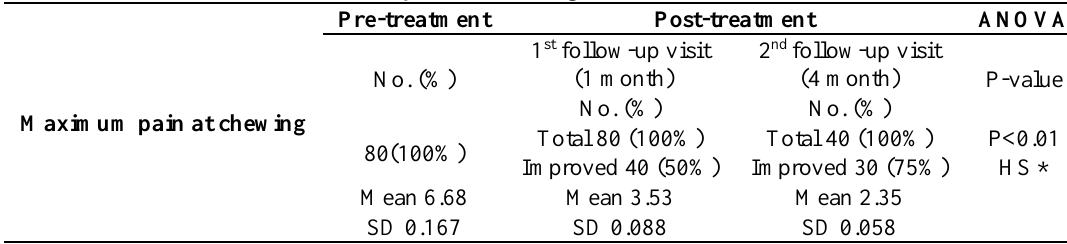
Table 2: Maximum pain at chewing (before and after treatment).